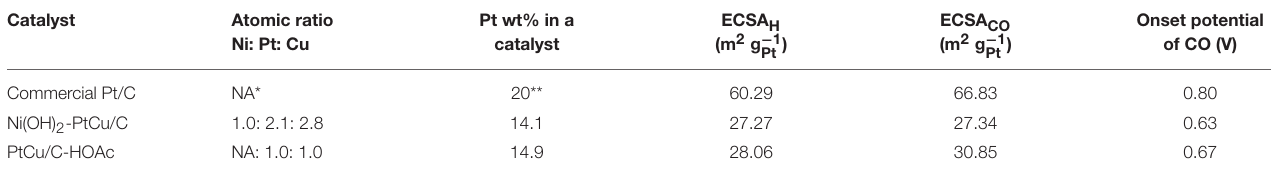
TABLE 1 | Comparison of atomic ratio and Pt wt% in a catalyst obtained by ICP-AES, H upd -based, and CO ads -based electrochemical surface areas (ECSA H , ECSA CO ), and onset potential of CO stripping. Catalyst